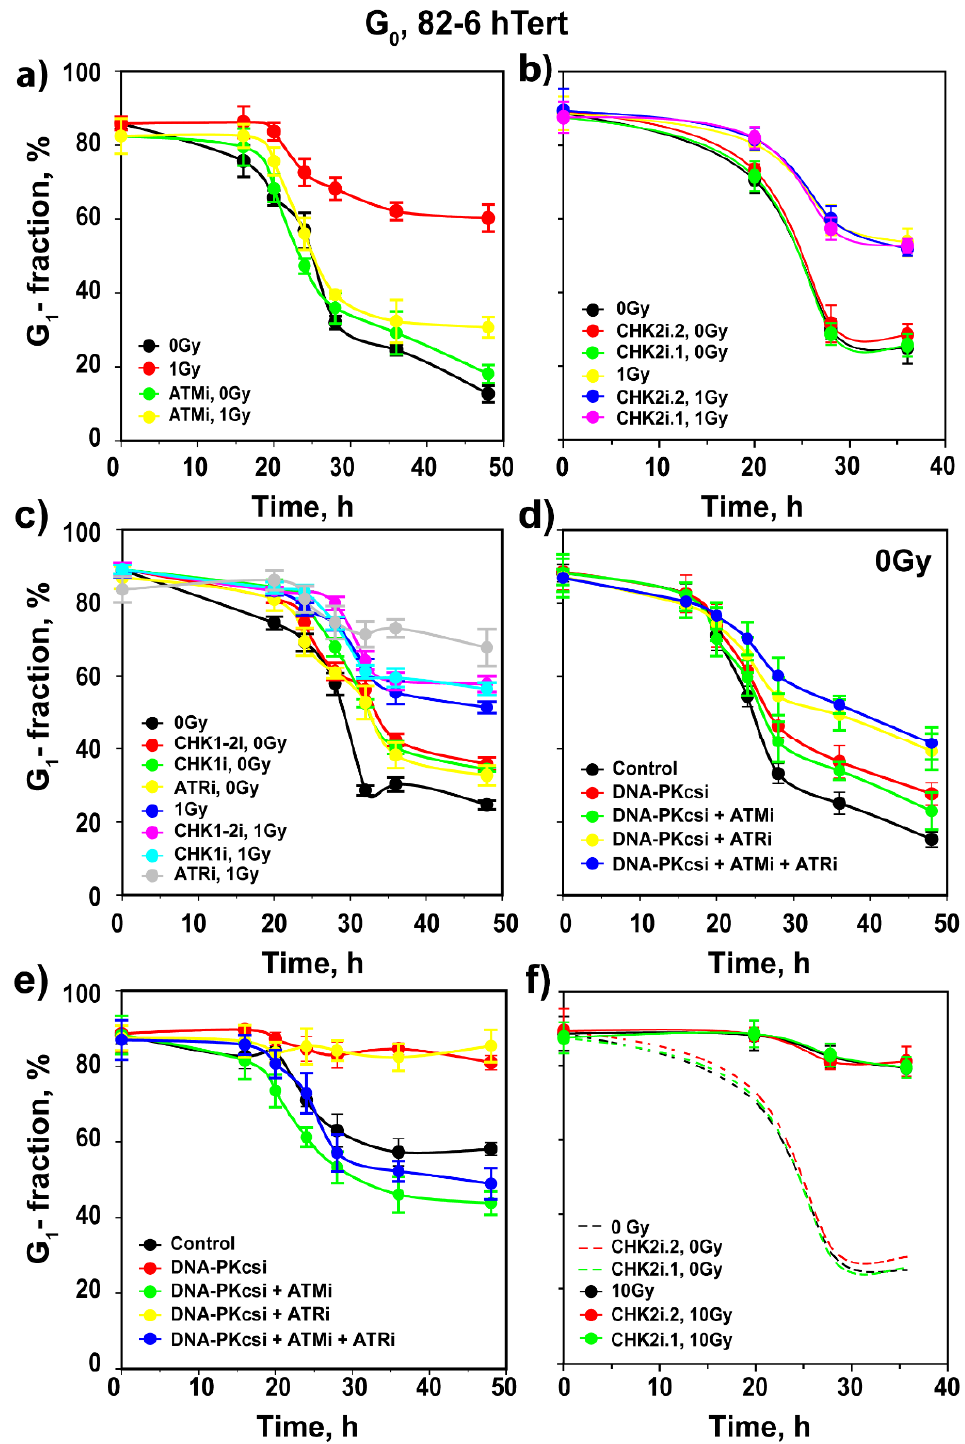
Figure 4. Assessment of the effects of ATM, ATR and DNA-PKcs inhibitors on the activation of G 1 checkpoint in irradiated G 0 cells of SD 82-6 hTert cell cultures. ( a ) As in Figure 1b for cells exposed to 0 or 1 Gy in the presence of ATMi as indicated. ( b ) As in ( a ) for cells exposed to CHK2 inhibitors as indicated. ( c ) As in ( a ) for cells exposed to CHK1 inhibitors as indicated. ( d ) As in ( a ) for unirradiated cells treated with DNA-PKcsi in the presence or absence of ATMi and or ATRi. ( e ) As in ( d ) for cells exposed to 1 Gy of X-rays. ( f ) As in panel ( a ), for cells exposed to 0 or 10 Gy in the presence or absence of a CHK2 inhibitor as indicated. Broken lines show results from ( b ) without data point to avoid congestion. Plotted is the mean and SE from three independent experiments. See also Table S3 for more